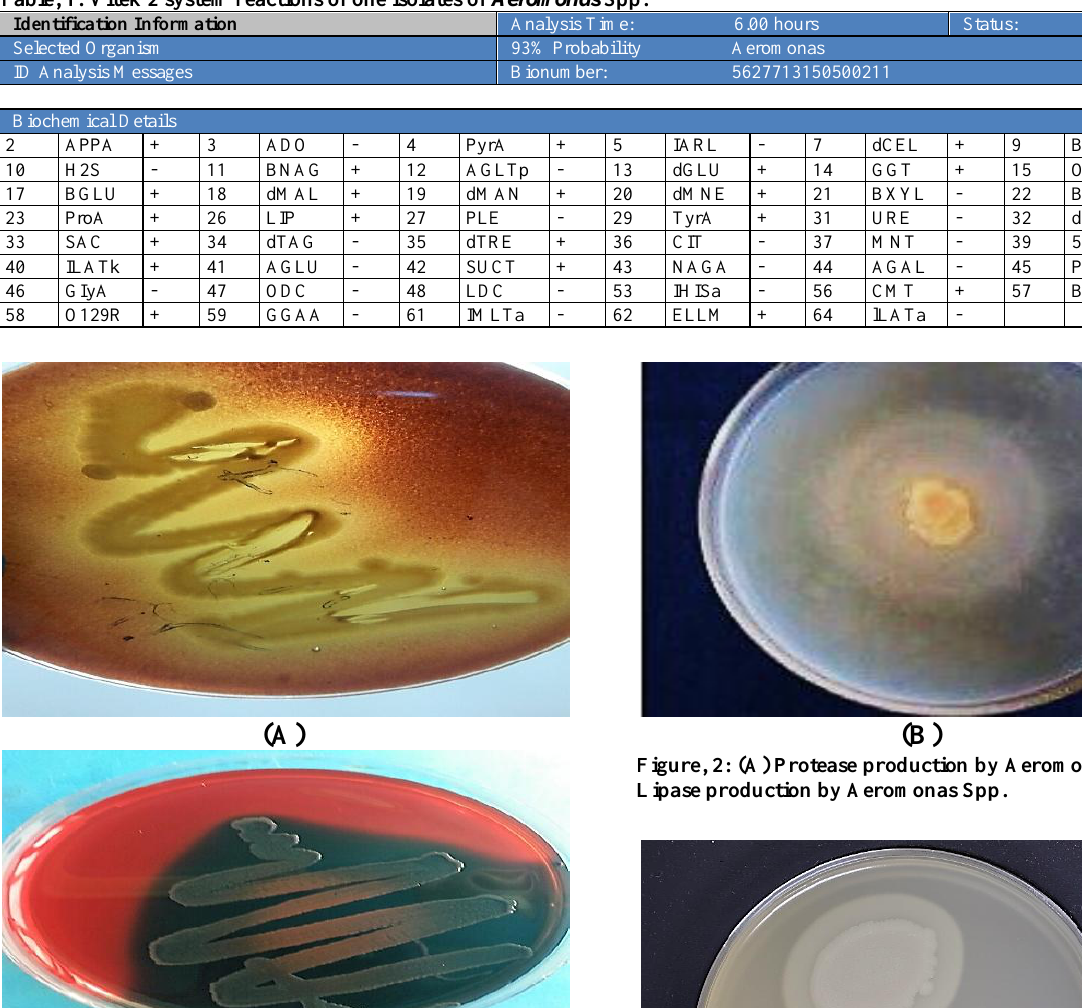
Table, 1: Vitek 2 system reactions of one isolates of Aeromonas Spp.